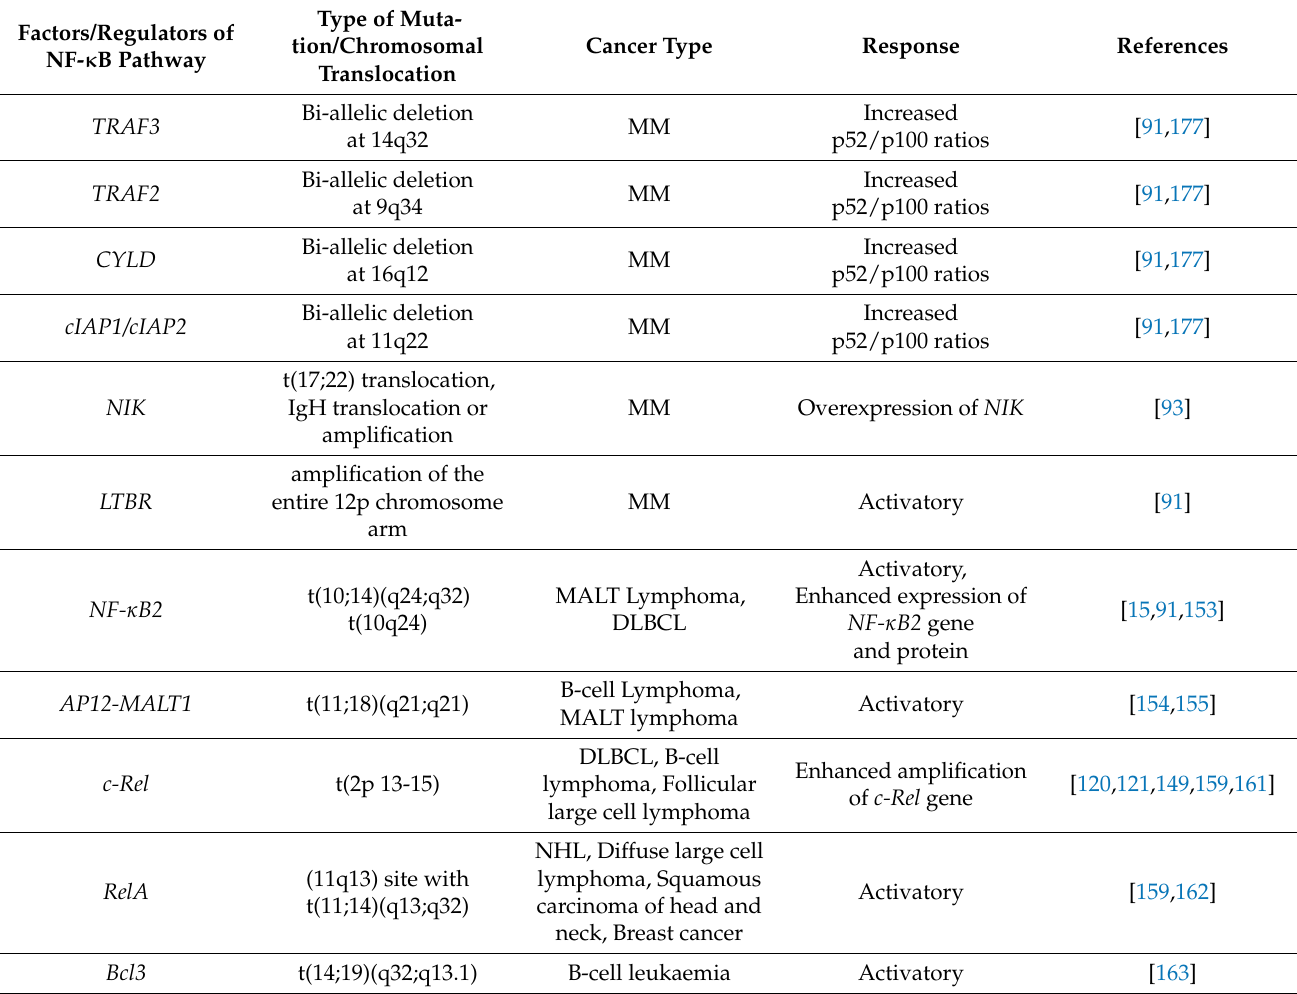
Table 2. Summarized table of various mutations/chromosomal alterations in components of NF- κ B pathway affecting its expression and activity in different cancer